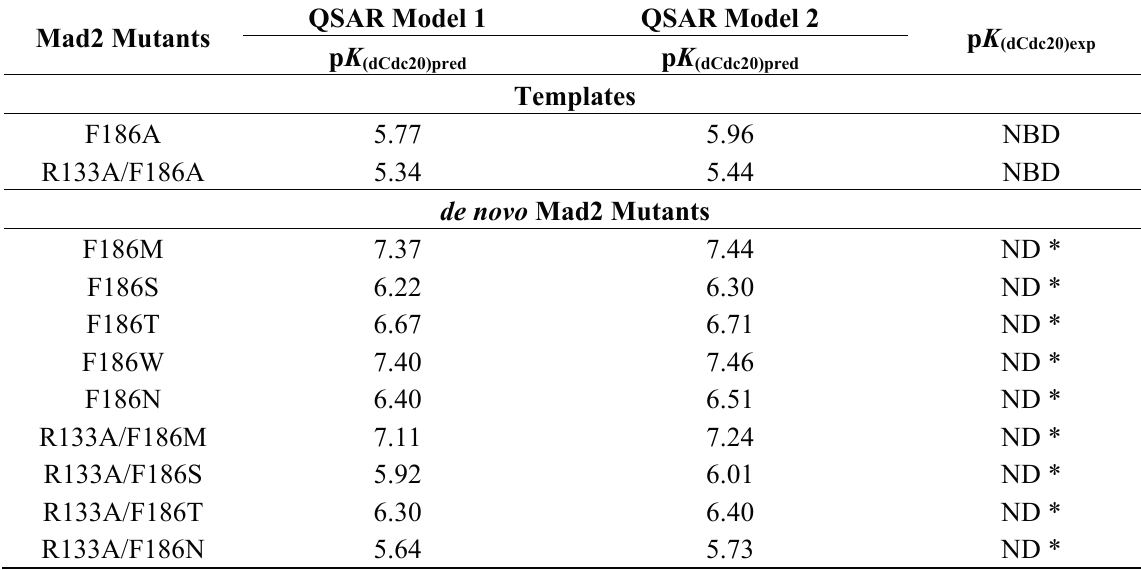
Table 3. Predicted p K dCdc20 of de novo Mad2 mutants and their templates by applying QSAR models 1 and